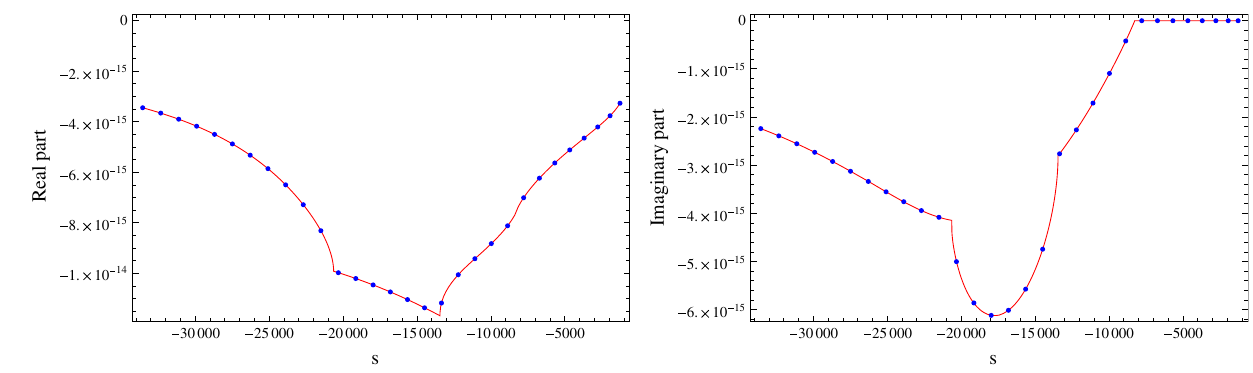
Fig. 9 Energy scan of a scalar pentagon. The red curve is done with LoopTools and the blue points are obtained with the LTD